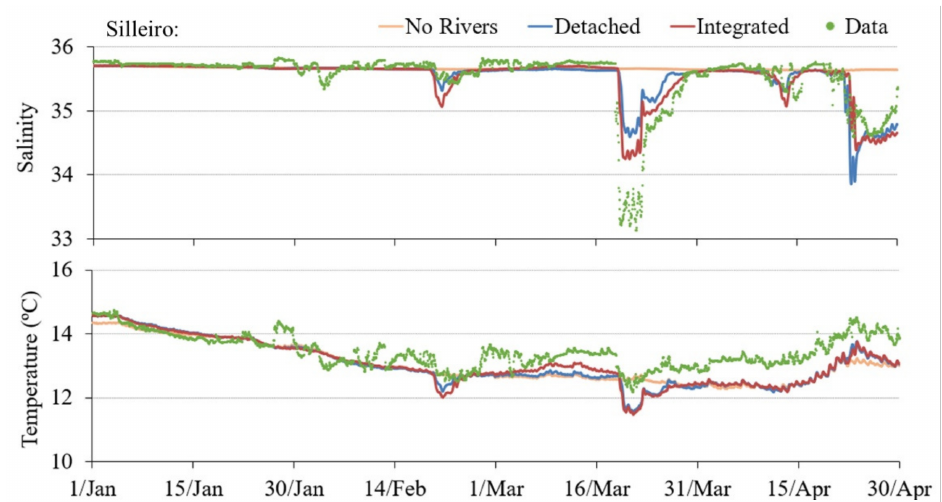
Figure 4. Salinity and temperature time series produced by the three PCOMS implementations and the Silleiro in situ moored buoy during the period between 1 January and 1 May 2018.